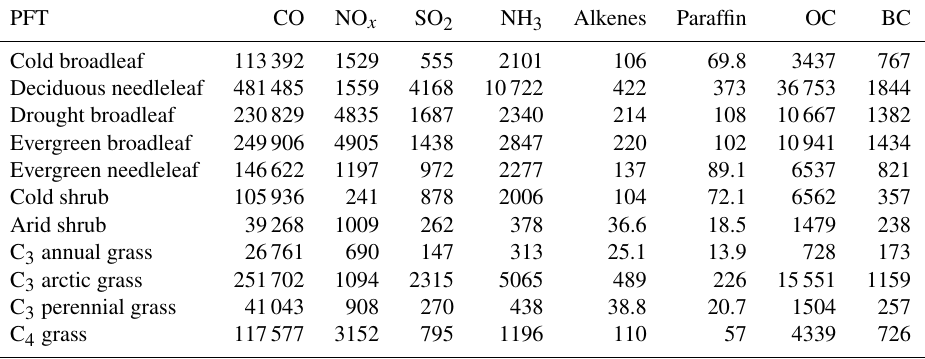
Table 1. Fire emission factors for the different plant functional types (PFTs) in ModelE2.1. Factors are in units of kilograms per fire per PFT in the grid cell. For organic carbon (OC) and black carbon (BC) units, kilograms is substituted with kilograms of carbon. PFT CO NO x SO